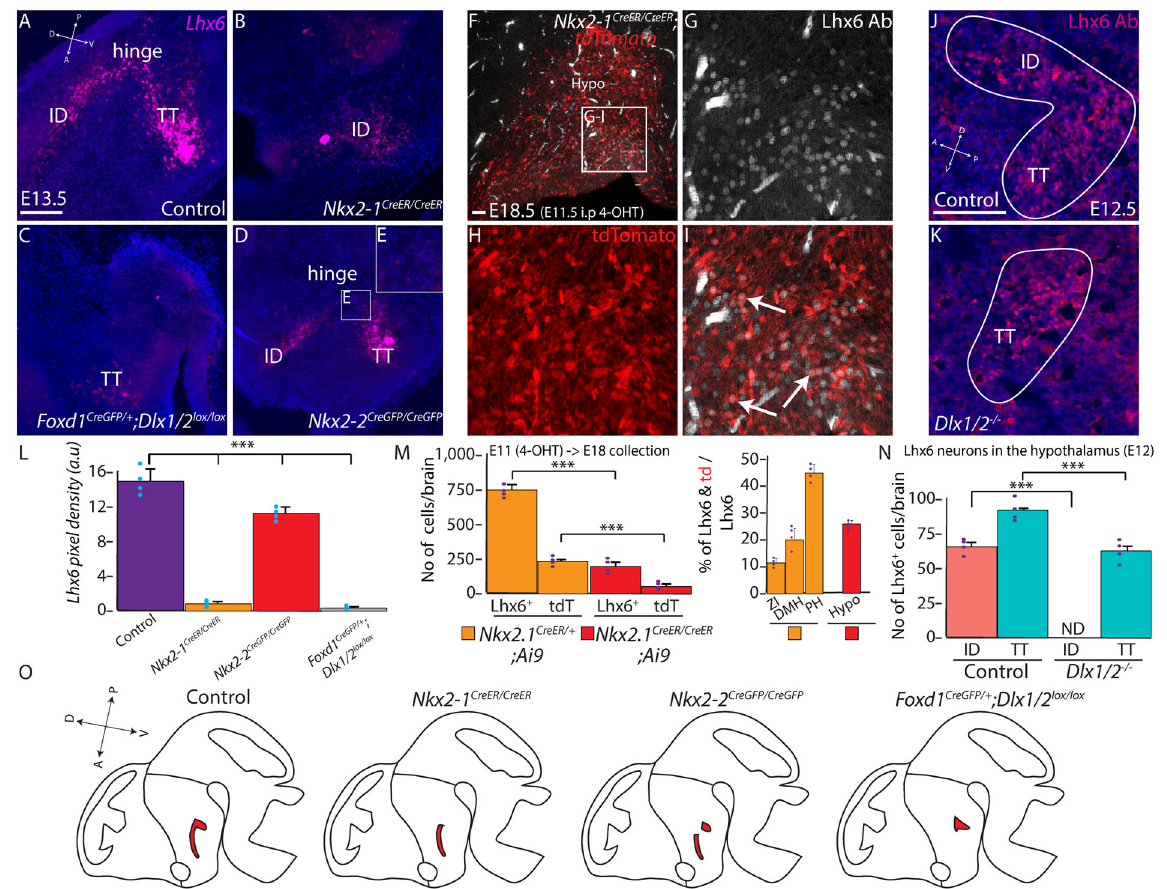
Fig. 6 Dlx1/2, Nkx2-2 , and Nkx2-1 mediate patterning of discrete spatial domains of hypothalamic Lhx6 neurons. A – E , L RNAscope showing Lhx6 expression (magenta) in control ( A ), Nkx2-1 CreER/CreER ( B ), Foxd1 Cre/ + :Dlx1/2 lox/lox ( C ), and Nkx2-2 CreGFP/CreGFP ( D , E ). Pixel density of Lhx6 is shown across all four groups in ( L ). F – I , M Nkx2-1 CreER/CreER; Ai9 (4-OHT treatment at E11.5, collection at E18.5) showing Lhx6 expression (gray) and tdTomato (red) in the hypothalamus. Arrows in ( I ) indicate Lhx6 + and tdTomato + neurons. Raw number of Lhx6 + or tdTomato + (tdT) neurons (left) and percentage of Lhx6 + and tdTomato + neurons (right) in Nkx2-1 CreER/ + ;Ai9 (Supplementary Fig. 5) and Nkx2-1 CreER/CreER /Ai9 . J , K , N Lhx6 expression (magenta) in control and Dlx1/2 − / − at E12 ID and TT. The number of Lhx6-expressing neurons in the ID and TT are shown in ( N ). O Schematic diagram showing distribution of Lhx6 expression across four groups. ID intrahypothalamic diagonal, TT tuberomamillary terminal. Scale bar = 50 μ m. *** p < 0.05. All bar graphs ( L , M , N ) show mean and standard error of the mean (SEM), with individual data points